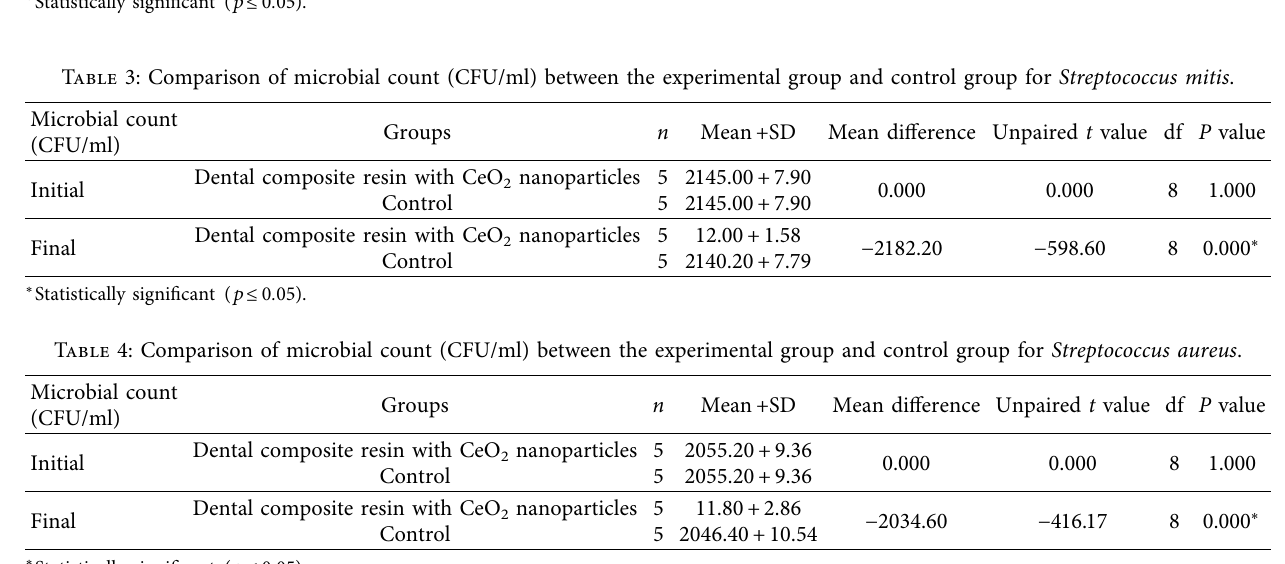
Table 2: Comparison of microbial count (CFU/ml) between the experimental group and control group for Streptococcus mutans . Microbial count (CFU/ml)